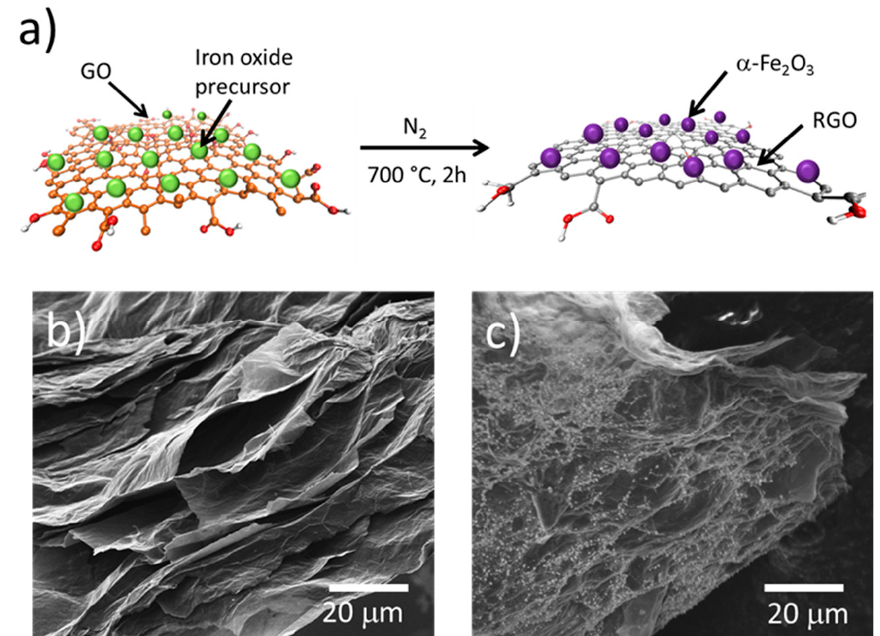
Figure 1. ( a ) Schematic of production of α -Fe 2 O 3 /RGO hybrid material by the simultaneous thermal reduction of graphene oxide (GO) and synthesis of iron oxide nanoparticles; ( b ) Scanning electron microscopy (SEM) image of RGO prepared by the thermal reduction at 700 °C as control and ( c ) SEM image of the resulting α -Fe 2 O 3 /RGO hybrid material.